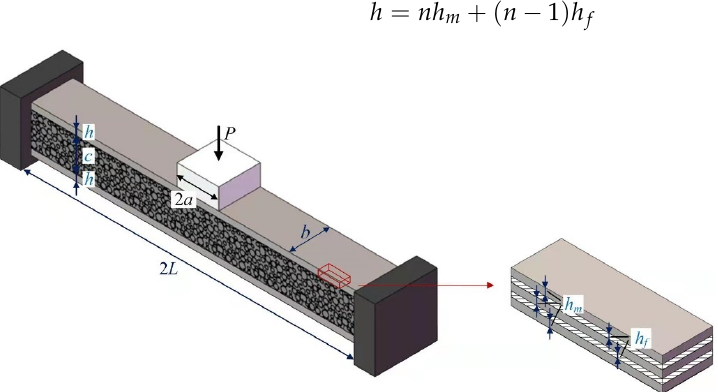
Figure 1. Schematic diagram of a fully clamped sandwich beam with fiber metal laminate face sheets and metal foam core transversely loaded by a flat punch at midspan.